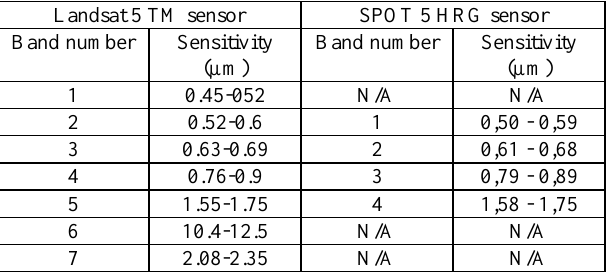
Table 1. Spectral characteristics of Landsat 5 TM and SPOT 5 HRG